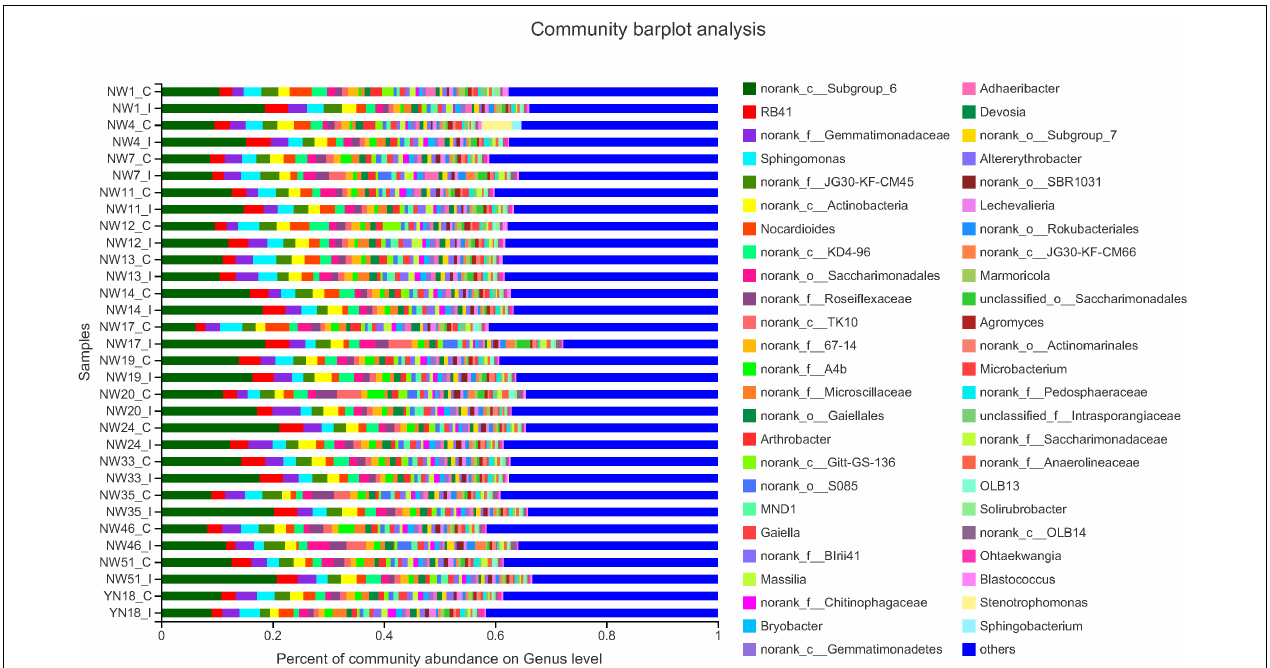
FIGURE 1 | Relative abundance of the dominant rhizosphere soil bacterial in 16 wheat cultivars. The relative abundances are based on the proportional frequencies of the DNA sequences that could be classified. The length of the colored bars indicates the average relative abundance in each sample group. C indicates control cultivar and I indicates infected wheat cultivar.